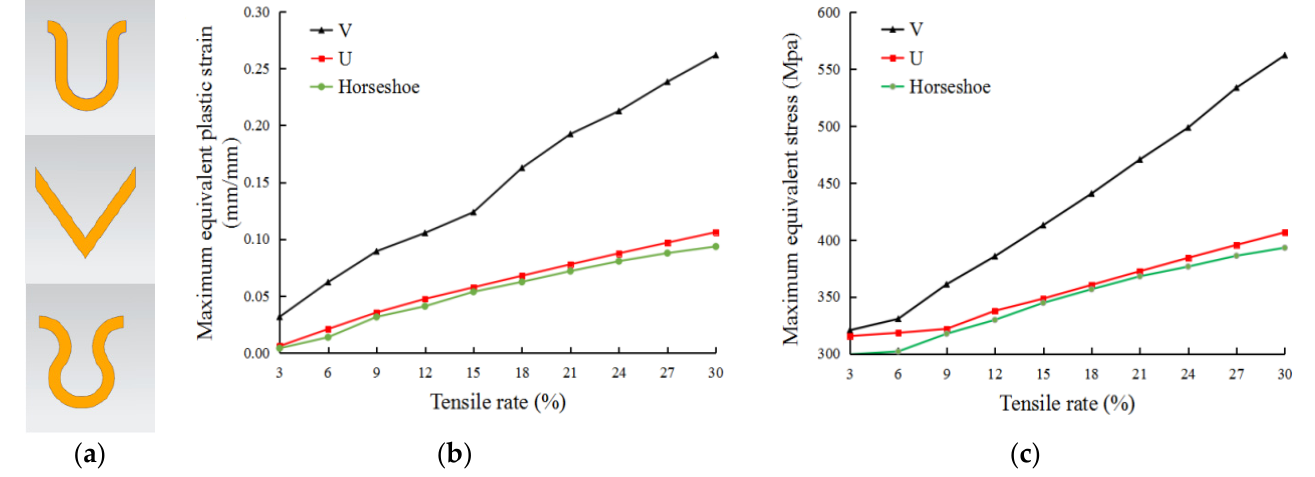
Figure 3. Finite element simulation of 3 types of interconnected electrode. ( a ) The 3 types of interconnecting electrodes; ( b ) relationship between maximum equivalent stress and tensile rate; ( c ) relationship between maximum equivalent plastic strain and tensile rate.